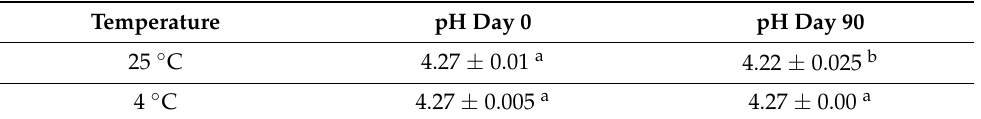
Table 2. Stability study of NE-FLO at different storage temperatures assessed using pH measurement at different storage times.